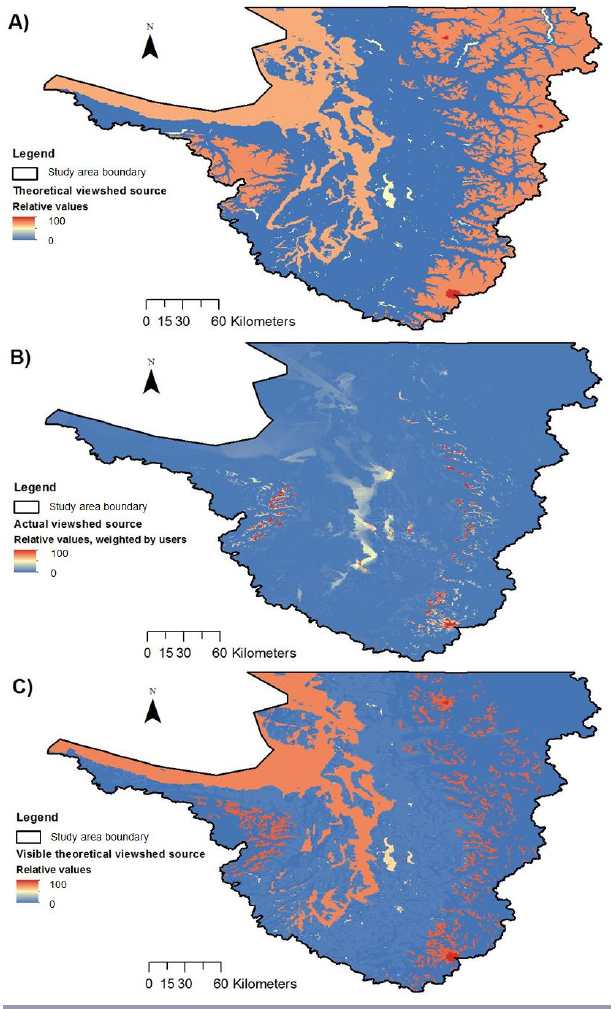
Fig. 4 . Theoretical and actual viewsheds in the Puget Sound Basin, showing (a) theoretical values, (b) actual values weighted by the number of homeowners, and (c) theoretical values actually visible to homeowners.